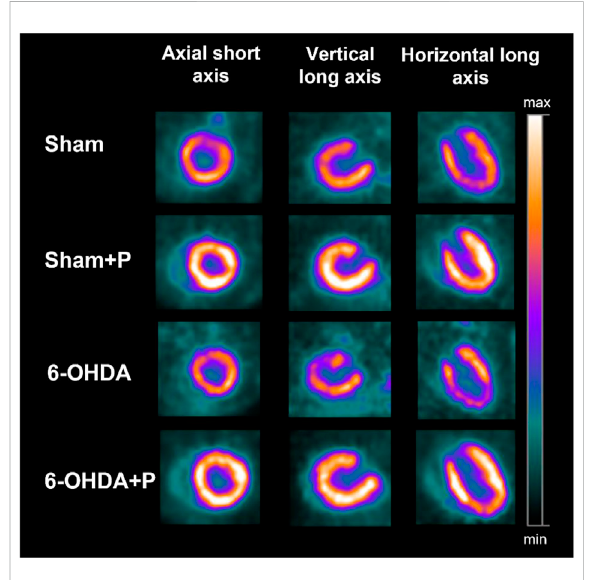
FIGURE 1 Illustrative [18F]FDG PET images showing the three cardiac axes (columns) of the different groups (lines). Note that the [18F] FDG uptake is higher in the sham + P and 6-OHDA + P groups.